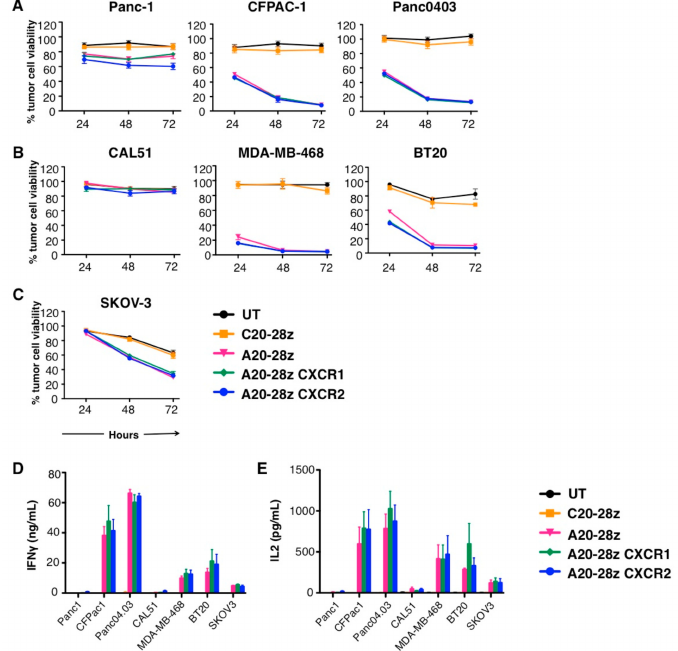
Figure 3. In vitro assessment of anti-tumor activity of chemokine receptor-expressing CAR T-cells targeted against α v β 6. Pancreatic ( A ), triple negative breast ( B ), or ovarian ( C ) tumor cells were co-cultivated at a 1:1 ratio with the indicated CAR T-cells in the absence of exogenous cytokine for 24–72 h. Data show the mean ± SEM of residual tumor cell viability from 3 independent experiments, each performed in triplicate and quantified by MTT assay. At each time-point, percentage tumor cell survival has been expressed relative to untreated tumor cells (set at 100% viability). Supernatant was collected and levels of IFN- γ (48 h; D ) and IL-2 (24 h; E ) quantified by ELISA. Data show the mean ± SEM of cytokine concentration detected in 3 independent